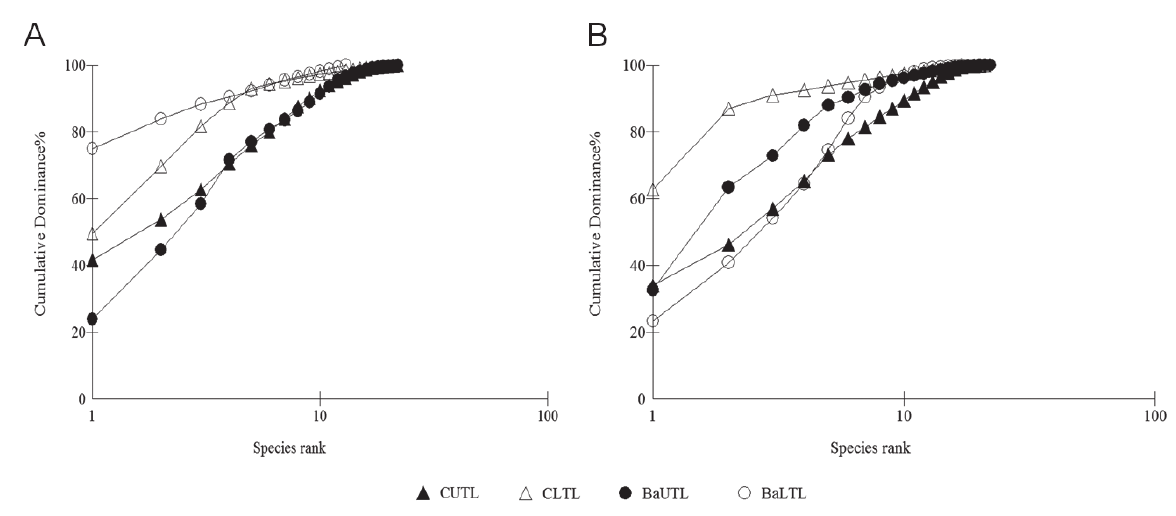
Fig. 4 - K-dominance curves for nematode genera data pooled over each tidal level. A: January, B: June. (CUTL: Coqueiros upper tide level, CLTL: Coqueiros low tide level, BaUTL: Bananal upper tide level, BaLTL: Bananal low tide